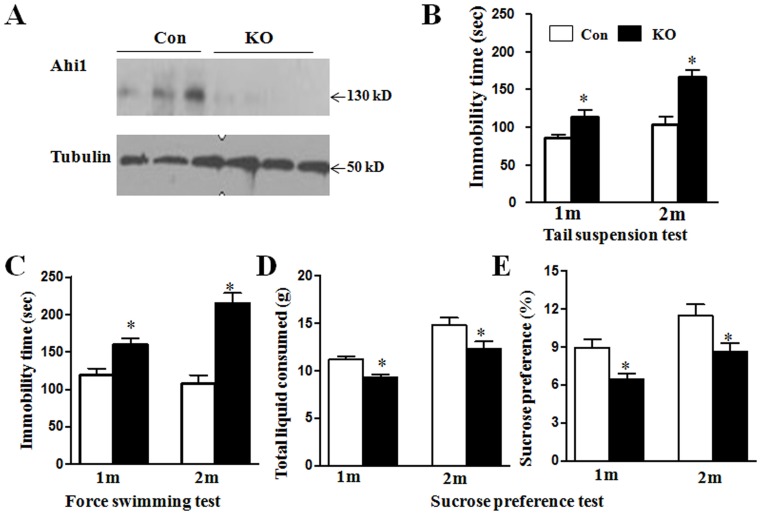
Ahi1 KO caused depressive behaviors in young mice.(A) Western blot analysis showed Ahi1 expression in the hypothalamic tissues from control mice and Ahi1 KO mice. (B) Immobility time in tail suspension test was shown in control mice and Ahi1 KO mice at the age of 1 m and 2 m. (C) Immobility time in forced swimming test was shown in control mice and Ahi1 KO mice at the age of 1 m and 2 m. (D and E) Sucrose preference test was performed and total consumed liquid (D) and the percentage of 1% sucrose (E) were calculated. *P<0.05 versus control mice. N = 6–8 mice.